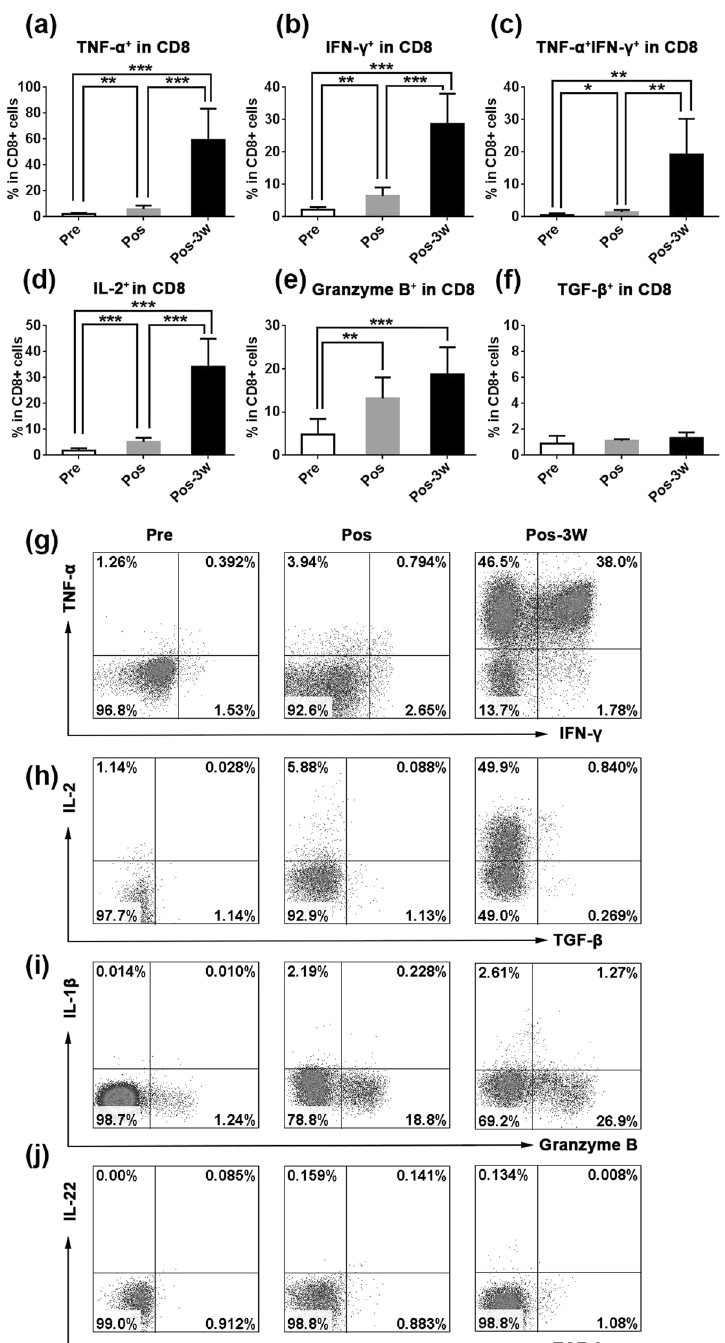
Figure 2. Expression profiling of cytokines expressed by CD8 + T cells in peripheral blood after HSRT. PBMCs were treated with a leukocyte activation cocktail for 6 h, and the cells were then collected and labeled with IFN- γ ( g ), TNF- α ( g ), IL-2 ( h ), TGF- β ( h ), IL-1 β (i ), granzyme B ( i ), or IL-22 ( j ). The mean values of the frequencies of TNF α + CD8 + T cells in CD8 + T cells ( a ), IFN γ + CD8 + T cells in CD8 + T cells ( b ), TNF α + IFN γ + CD8 + T cells in CD8 + T cells ( c ), IL-2 + CD8 + T cells in CD8 + T cells ( d ), granzyme B + CD8 + T cells in CD8 + T cells ( e ), and TGF β + CD8 + T cells in CD8 + T cells ( f ) were analyzed at the indicated times. The panel g–j showed the representative result from one patient. The data are shown as the mean values ± SEM (n = 6). Statistics were derived using ANOVA with Bonferroni’s post-test. * p < 0.0167, ** p < 0.01; *** p <